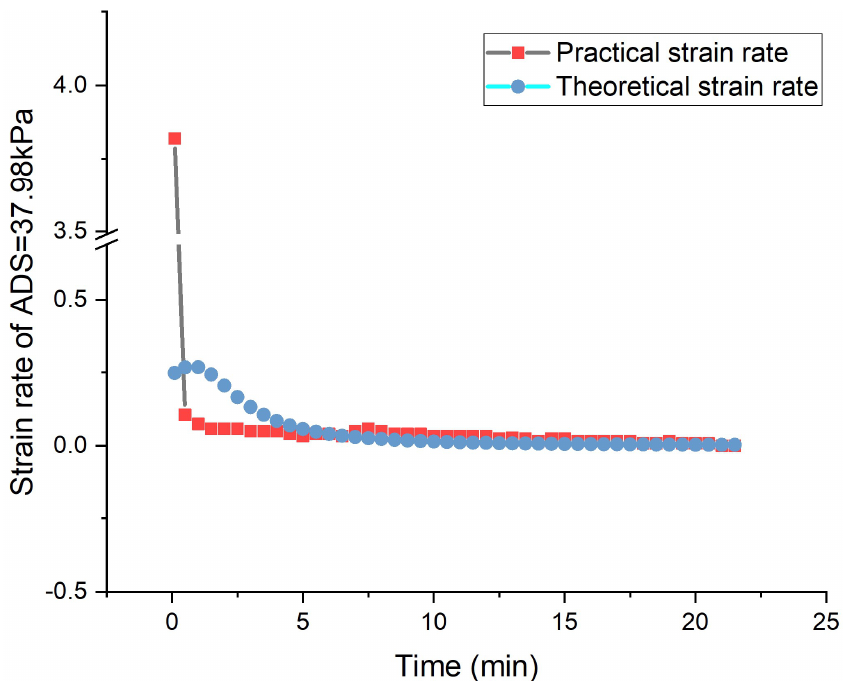
Figure 37. Comparison of theoretical and practical strain rate–time of ADS = 37.98 kPa of Specimen 23.